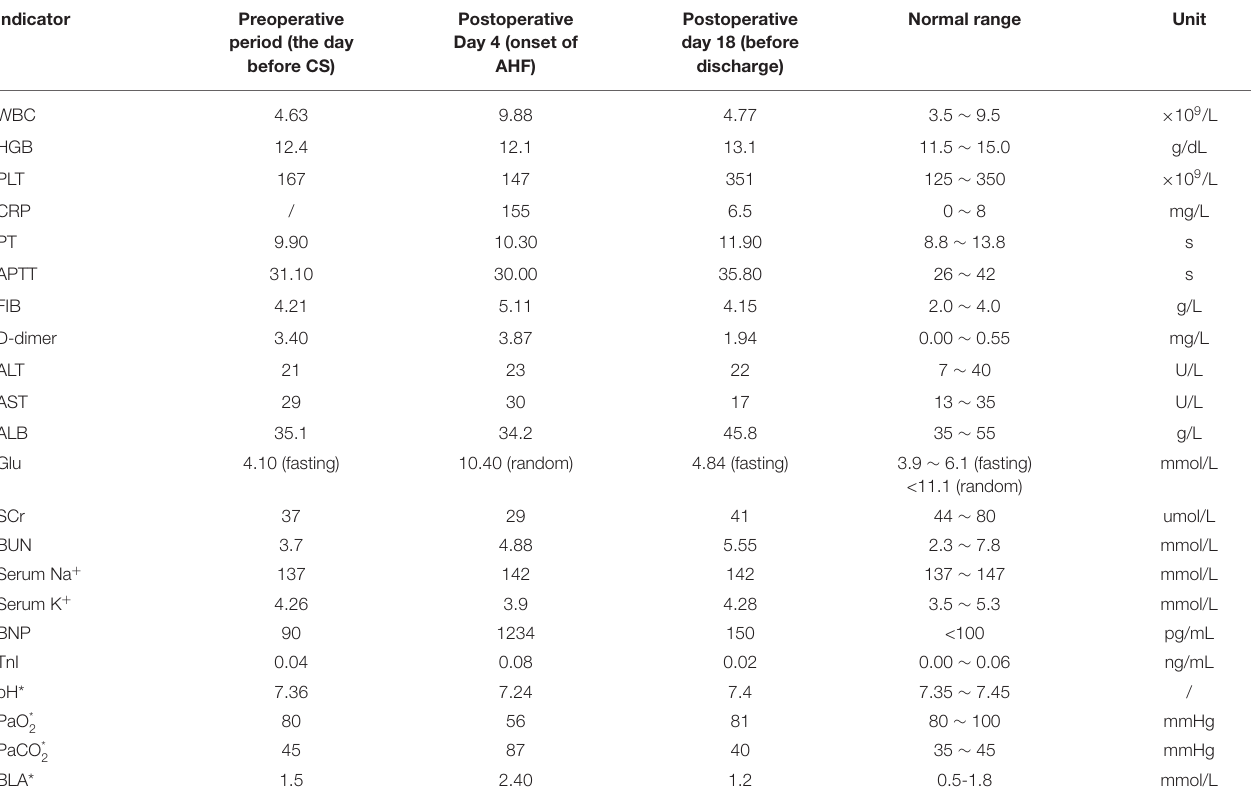
TABLE 1 | Laboratory data of the patient during her hospitalization. Indicator Preoperative